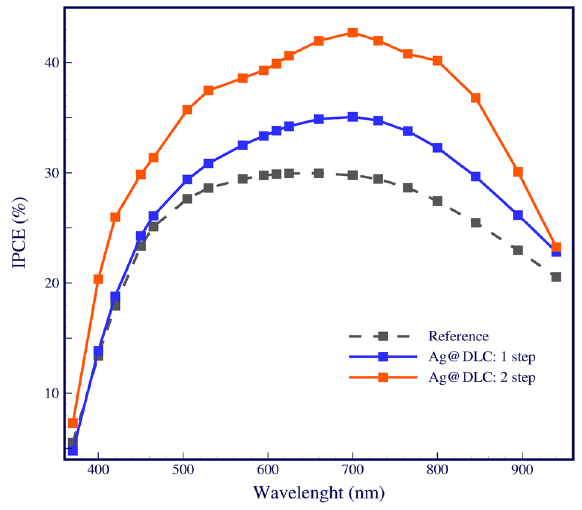
Figure 6. Incident photon to current efficiency (IPCE) spectra of the bare cell, monolayer and bilayer Ag nanoparticles solar